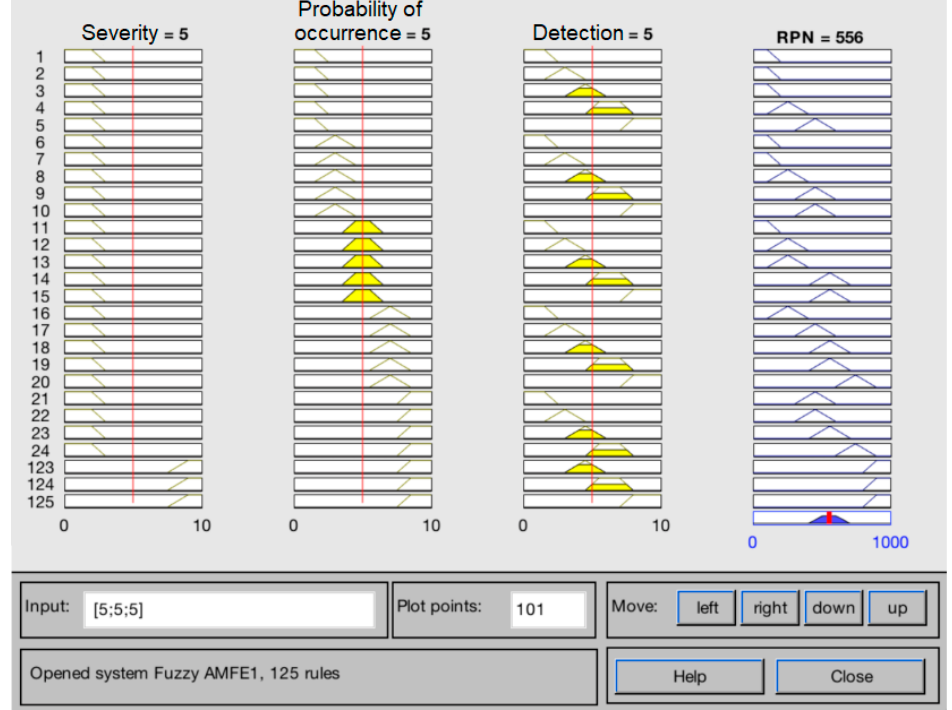
Figure 4. Partial view of the inference process in MATLAB